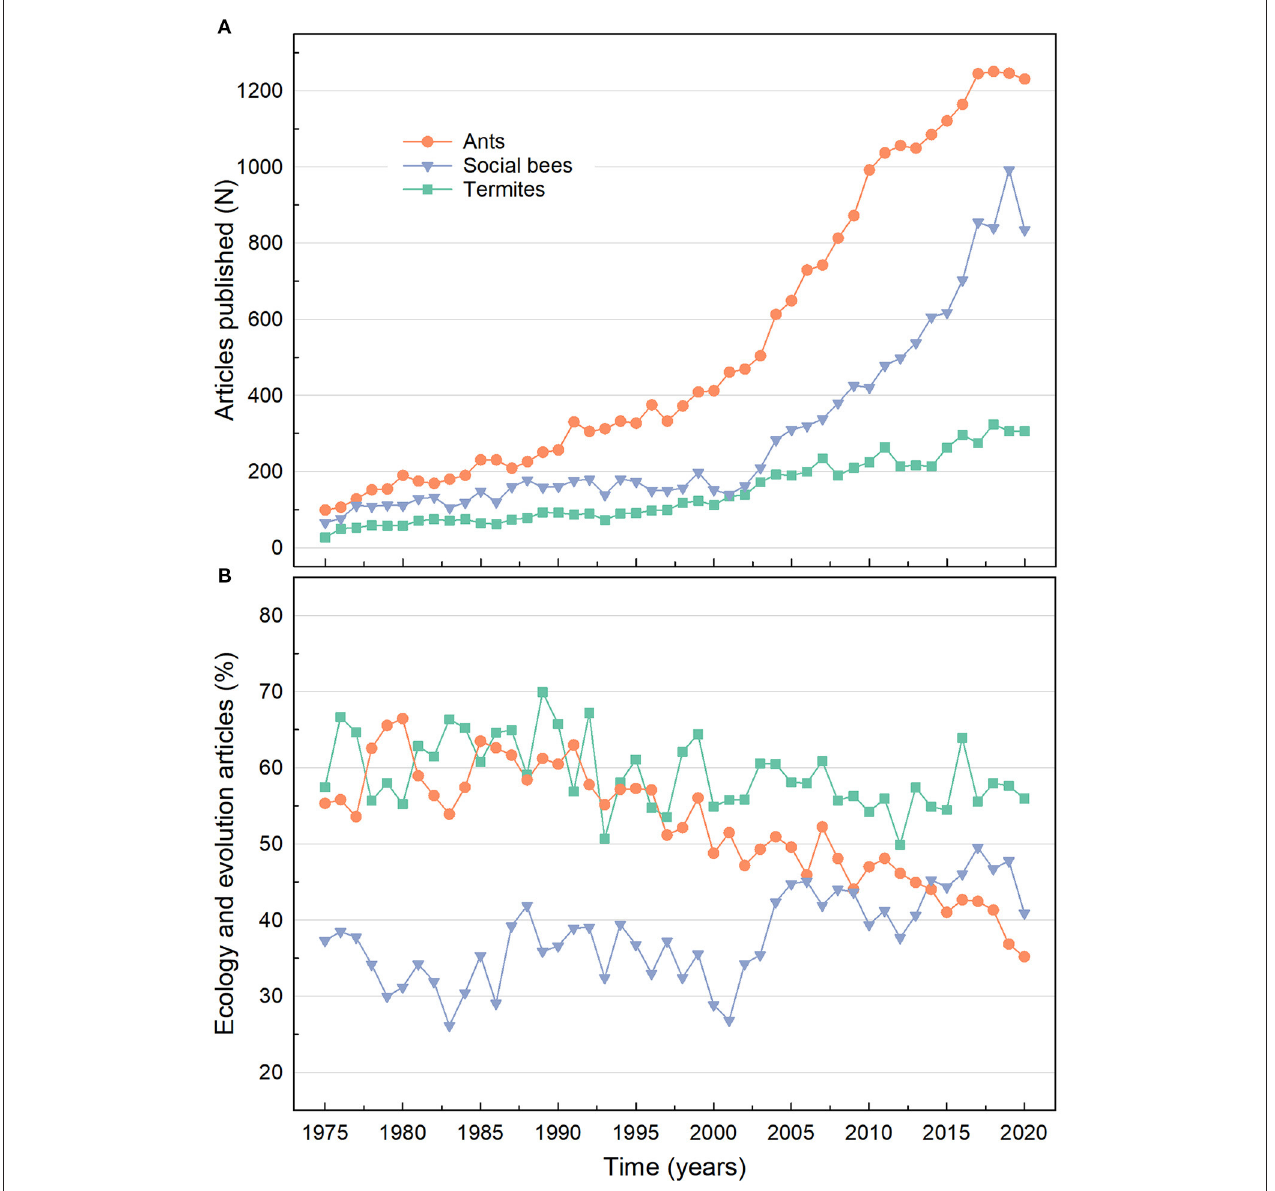
FIGURE 1 | Articles published for ants, social bees, and termites from 1975 to 2020 in all databases available on ISI Web of Knowledge. (A) Number of articles published by year for ants (keyword search: “ants”); social bees (keyword search: “orchid bees OR bumble bees OR stingless bees OR honey bees”), and termites (keyword search: “termites”). (B) Percentage of articles published by year on ecology or evolution topic for ants [keyword search: “ants AND (ecology OR evolution)”], social bees [keyword search: “(orchid bees OR bumble bees OR stingless bees OR honey bees) AND (ecology OR evolution)”], and termites [keyword search: “termites AND (ecology OR